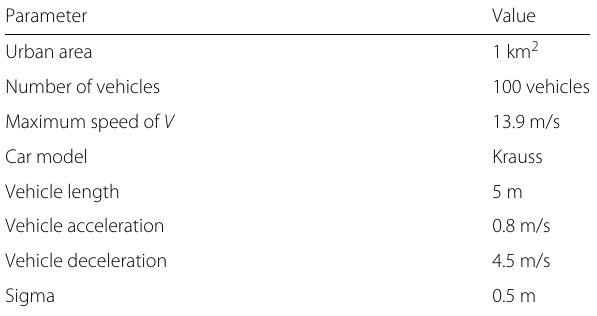
Table 5 SUMO configuration parameters